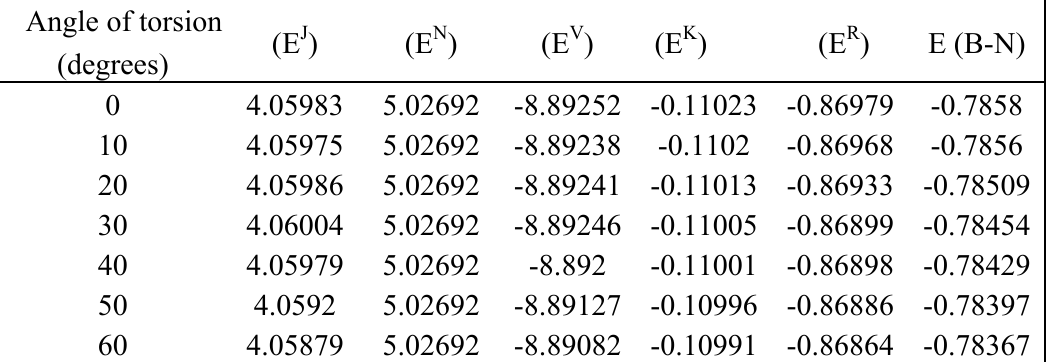
Table 8. ‘ B–N’ bond energy and its physical components (a.u.) as a function of torsional angles.